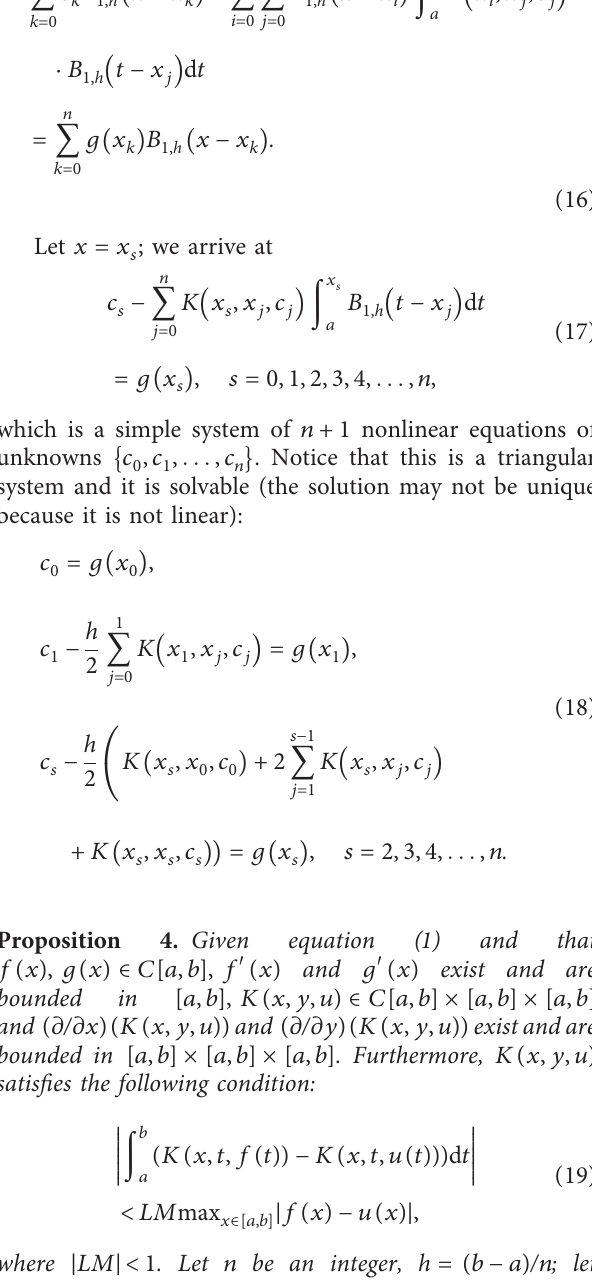
Figure 3: The graph of L